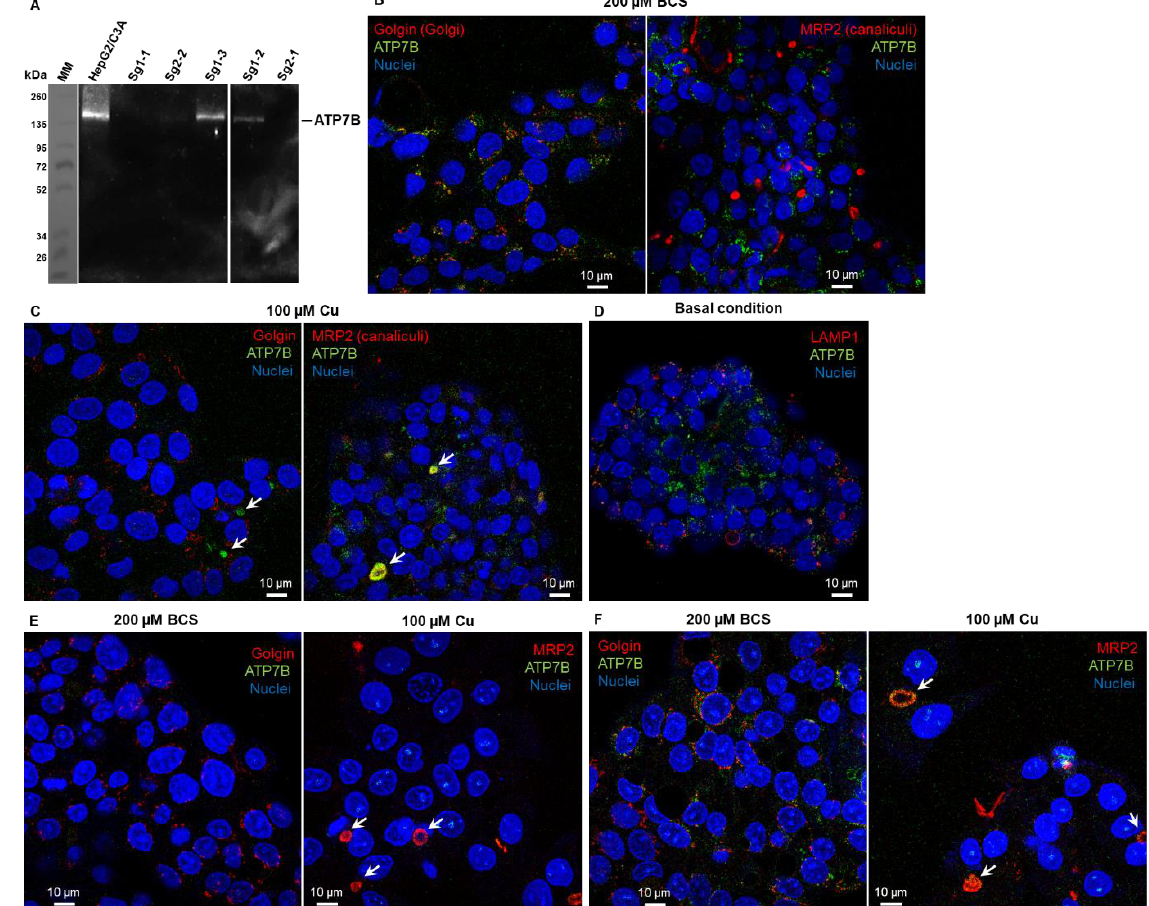
Figure 1. Characterization of CrispR/Cas9-modified HepG2/C3a cell lines. ( A ) Western blot analysis of the expression of ATP7B in the HepG2/C3a cell line and in different clones isolated after the CrispR/Cas9 process. Confocal fluorescence microscopy revealed that ATP7B (green) is localized in the Golgi apparatus (red) in HepG2/C3a cells in Cu‑deprived conditions (exposure to the Cu chelator BCS) ( B ) and localized at bile canaliculi (white arrows) upon Cu exposure (100 µM) ( C ). In basal Cu conditions, ATP7B is in an intermediate location ( D ). Immunofluorescence analysis confirmed the absence of ATP7B in the sg1‑1 cell line ( E ) and its presence in the sg1‑3 cell line ( F ). Expression analysis was further confirmed by immunofluorescence analysis of